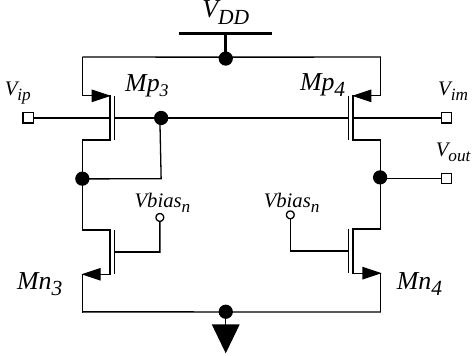
Figure 2. Proposed schematic of the error